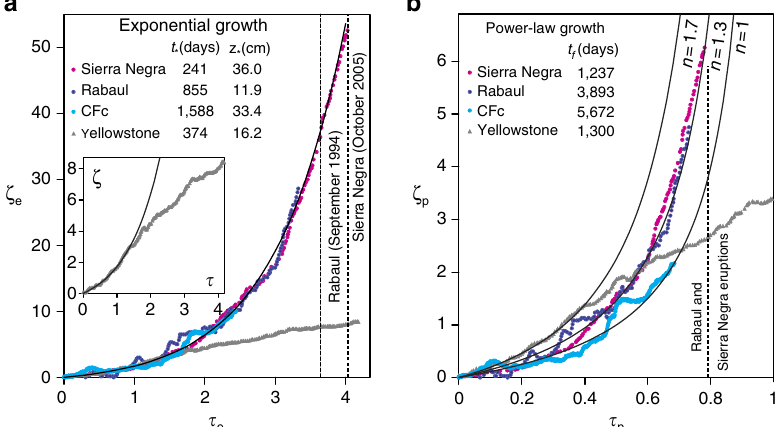
Figure 7 | Examples of several-years-long accelerating deformation patterns at selected key volcanoes. The curves indicate the vertical ground displacement observed at the different volcanoes (Sierra Negra magenta, Rabaul blue, CFc cyan, Yellowstone gray; see Methods). The patterns can be fitted with either exponential ( a ) or power-law ( b ) growth curves. ( a ) The dimensionless time ( t e ) and vertical displacement ( z e ) are given by t e ¼ t/t * and z e ¼ z/z * , respectively, where t * and z * are the characteristic time and vertical displacement, respectively, of the exponential curve: z ( t ) ¼ z * [ exp ( t/t * ) (cid:2) 1]. (cid:2) (cid:3) , respectively, where t ( b ) The dimensionless time ( t p ) and vertical displacement ( z p ) are given by t p ¼ t/t f and z p ¼ z = C = t n f C , and n the adjustable f parameters of the power-law curve: z t ð Þ ¼ C = t f (cid:2) t ð Þ n (cid:2) C = t n . The initial time for each case refers to the first evidence of uplift. Different curve parameters f are reported in the figure legends; the values of C (10 4 (cid:3) cm (cid:3) days n ) are 43.0, 33.8, 12.0, 67.2 for Sierra Negra, Rabaul, CFc, and Yellowstone, model relationship in Supplementary Fig. 4a. The obtained time dependence of the multiphase (gas/liquid) fluid and heat through a porous medium. The TOUGH2 CO 2 /H 2 O ratio (see red line in Supplementary Fig. 5b) was sampled at specific time version used here takes into account the contemporaneous presence of two intervals to infer the magmatic gas CO 2 /H 2 O ratio composition of each IMF event fluid components (H 2 O and CO 2 ) at subcritical temperature conditions 26 . (Supplementary Table 1). The degassing decompression trend (that is, from 200 to More-recent geothermal simulators 65 can also work at supercritical temperature 130MPa) of this model is schematically illustrated by the orange lines in Fig. 1a,d. conditions, but we used TOUGH2 to allow comparisons with previous work at The energy transported by volatiles while they are degassed from magma CFc 13,66,67 . The model includes heat flow occurring by both conduction and (Fig. 1b) was calculated from the enthalpy of the separated H 2 O–CO 2 mixture at convection, with the latter including both sensible and latent heat effects 26 . the magma temperature and pressure. The method 63,64 we used can simulate The model does not account for either the presence of other gas components, solute transport, and chemical reactions, or for deformation or fracturing of the properties of a binary CO 2 –H 2 O mixture up to supercritical conditions. However, porous rock. we injected magmatic fluids into the virtual hydrothermal system at 350 (cid:2) C in both The physical model calculations included defining the computational domain, Simulations 1 and 2. This is because the geothermal simulator that we used achieving steady-state conditions before simulating IMF events, selecting the (TOUGH2 (ref. 26)) can only work below the critical-point temperature of water. number and timing of IMF events, and calculating the mass of fluids injected in Enthalpies of the magmatic gas phase at 350 (cid:2) C were calculated using the EOS2 each IMF event. These steps are described in detail below. module 26 . This yielded that the enthalpies of the injected magmatic gases were far The computational domain consists of 850 cells distributed in a two- lower than those of magma-released supercritical fluids (Fig. 1b). This difference dimensional radial space of 2,000m (cid:3) 2,500m (Fig. 4). This domain is similar accounts for the energy lost by fluids as they pass thorough the plastic zone, to (but 500m deeper than) that used in previous simulations 66–69 of the CFc between the magma and the overlying hydrothermal system. TOUGH2 is a numerical simulator for geothermal systems that is fully hydrothermal system 13 . The top boundary is at fixed (atmospheric) temperature described elsewhere 26 . Briefly, TOUGH2 includes the coupled transport of a and pressure conditions, while other boundaries are impermeable and adiabatic.